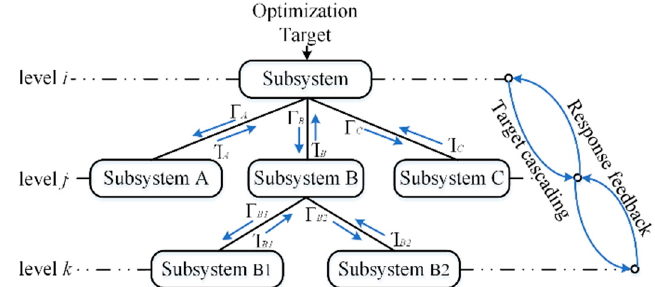
Figure 3. Conceptual schematic outline of the RMG, where the solid black line with an arrow represents power flow.